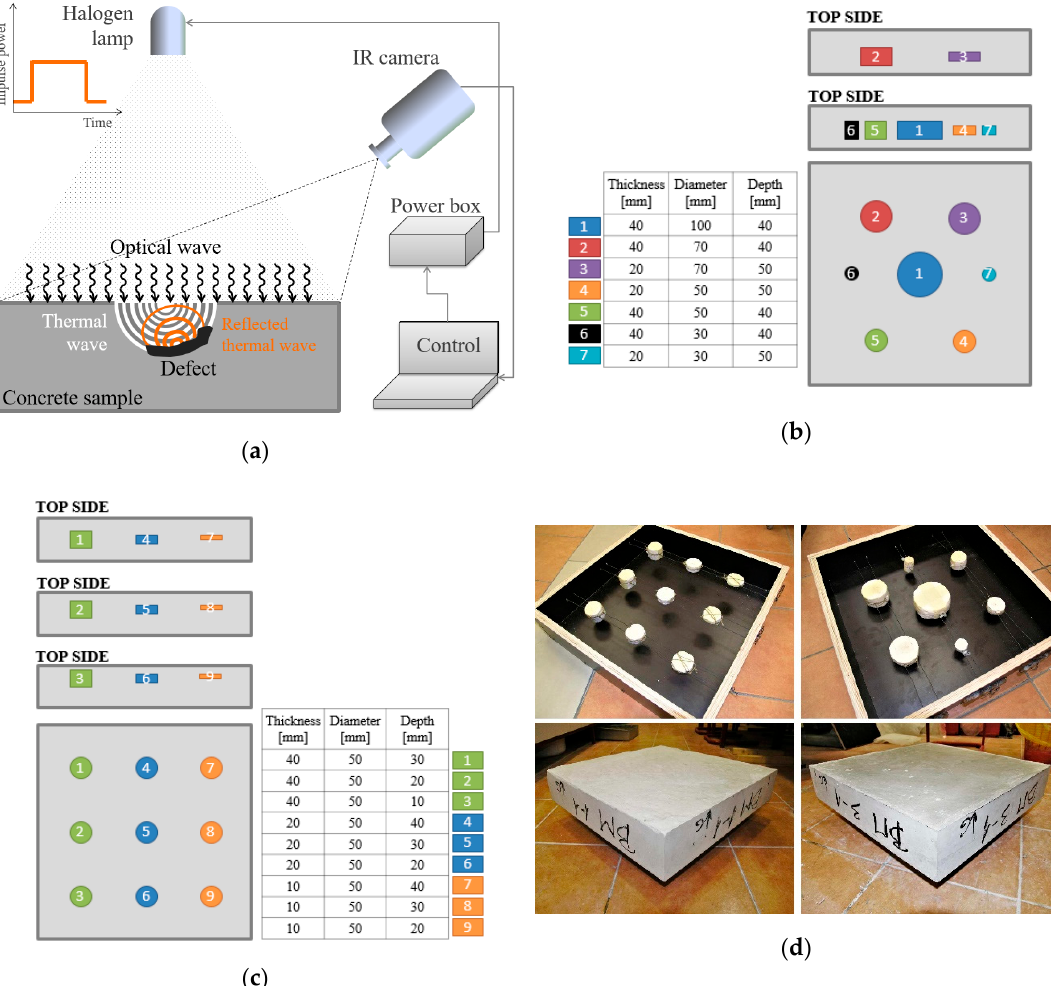
Figure 3. Schematic representation of: ( a ) data acquisition system; ( b ) samples BM x-1; ( c ) samples BM x-2; ( d ) photos of concrete samples and XPS defects.